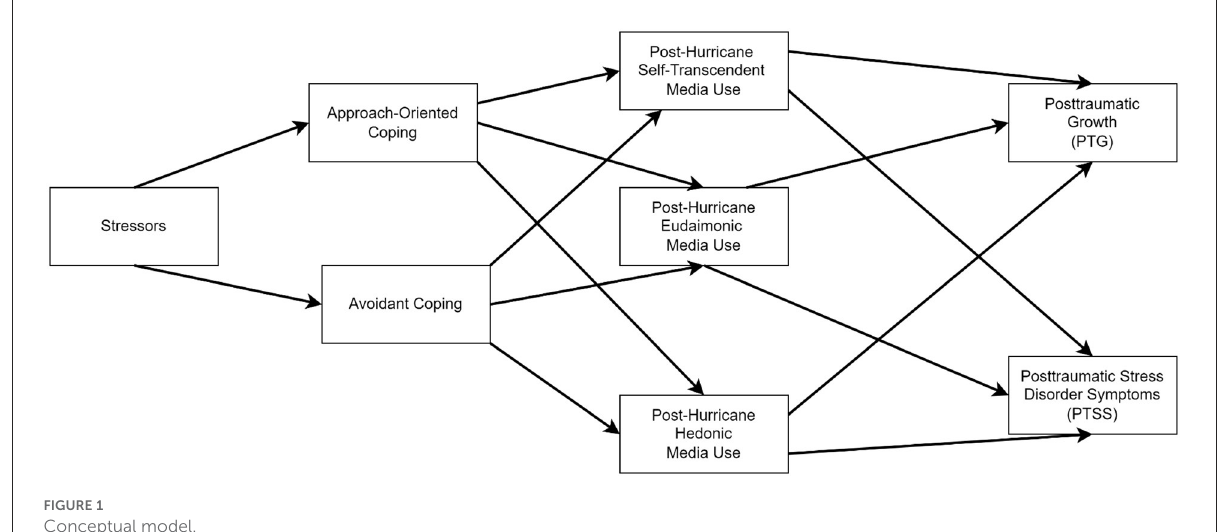
FIGURE1 Conceptual